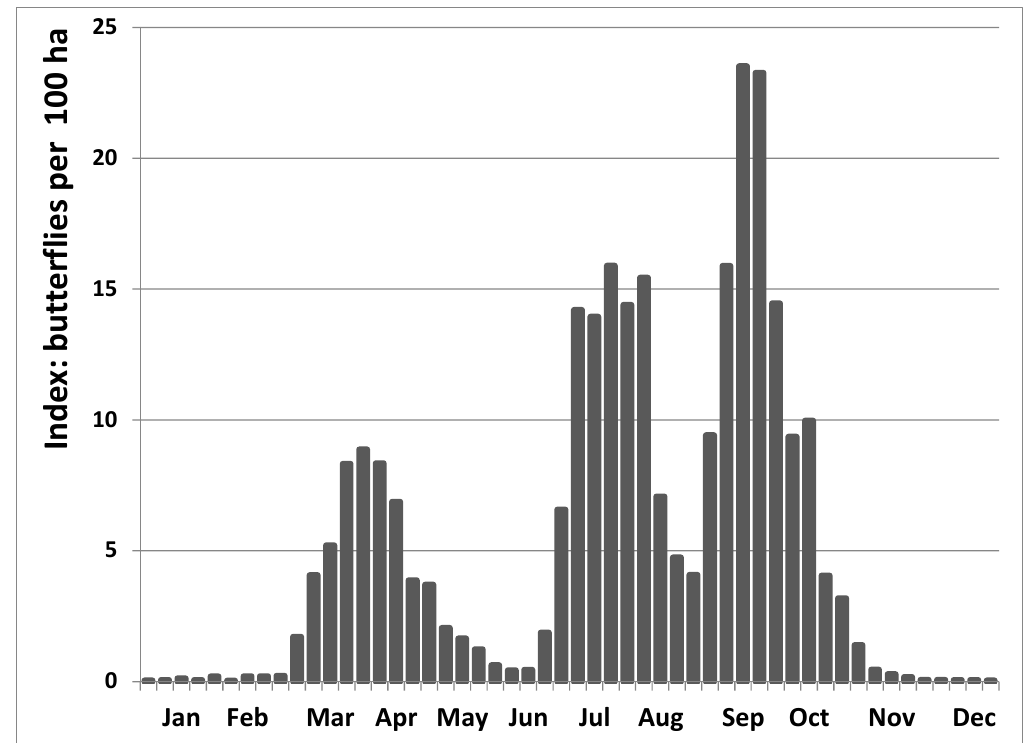
Figure 2. Abundance indices per week of peacock butterflies in Belgium (2009–2020): number of butterflies reported ( n = 178,874) relative to the number of visited hectares (day-grid-visits: n = 3,407,664) for the three best days of the week (see methods).